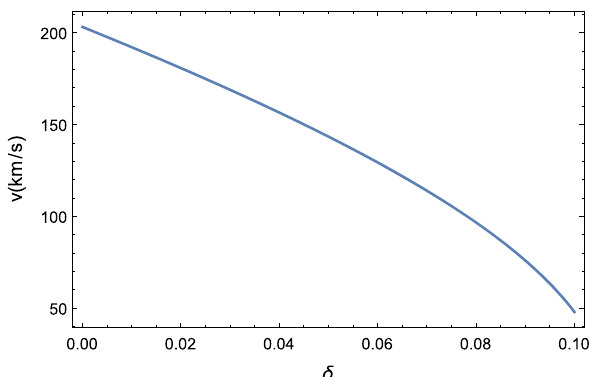
Fig. 1 The theoretical effective f ( R ) rotation velocity curve for a typ- ical massive galaxy shows the variation w.r.t. the parameter δ < 1 with r 0